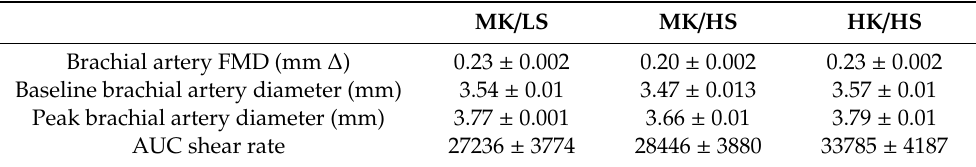
Table 3. Vascular measurement responses to dietary potassium and sodium perturbation. MK / LS MK / HS HK / HS Brachial artery FMD (mm ∆ ) 0.23 ± 0.002 0.20 ± 0.002 0.23 ± 0.002 Baseline brachial artery diameter (mm) 3.54 ± 0.01 3.47 ± 0.013 3.57 ± 0.01 Peak brachial artery diameter (mm) 3.77 ± 0.001 3.66 ± 0.01 3.79 ± 0.01 AUC shear rate 27236 ± 3774 28446 ± 3880 33785 ± 4187 Values are mean ± SE. AUC, area under the curve; FMD, flow-mediated dilation; HK / HS, high potassium / high sodium; MK / HS, moderate potassium / high sodium; MK / LS, moderate potassium / low sodium.